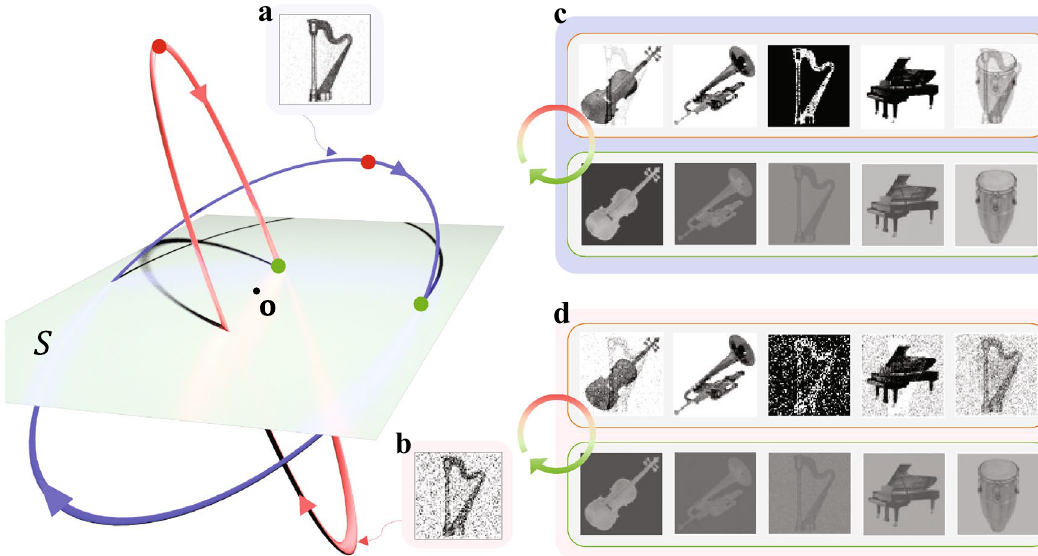
Figure 4. Comparison of retrieval quality according to the noise level in the cue. ( a ) The less noisy cue. The cue is generated in the same way as in Fig. 3 except using f 3 and r 3 instead of f 1 and r 1 . Gaussian noise are N R 642 ( 0, (cid:31) f 3 (cid:31) ) and N R 5 ( 0, 1 ) , respectively. The parameters are α = 0.1 and β = 0.2 . (b) The severely contaminated cue with α = 0.7 . (c) Snapshots of the retrieved images from the less noisy cue in (a), taken at the farthest point from S (top row) and at the intersection (bottom row). Here, p ( t † ) ≈ 0.0271 , and p ≈ 0.0899 . (d) Snapshots of the retrieved images from the more noisy cue in (b), taken at the farthest point from S (top row) and at the intersection (bottom row). Here, p ( t † ) ≈ 0.0194 , and p ≈ 0.0688 .